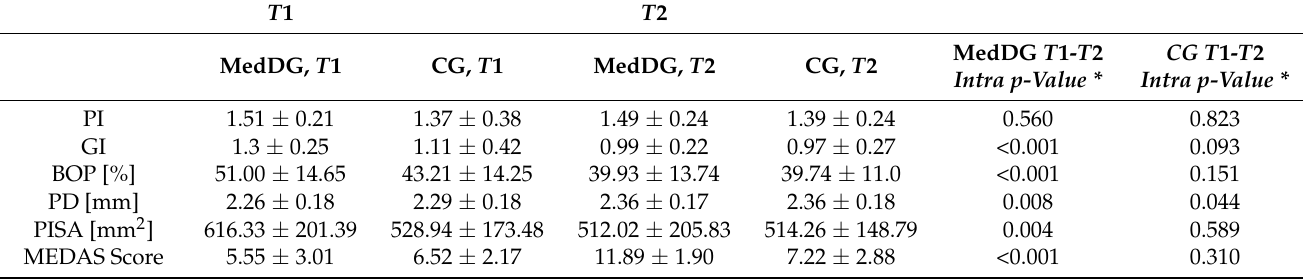
Table 2. Clinical data with mean values and standard deviations, * paired t -test, PI = plaque index, GI = gingival index, BOP = bleeding on probing, PD = pocket depth, PISA = periodontal inflamed surface